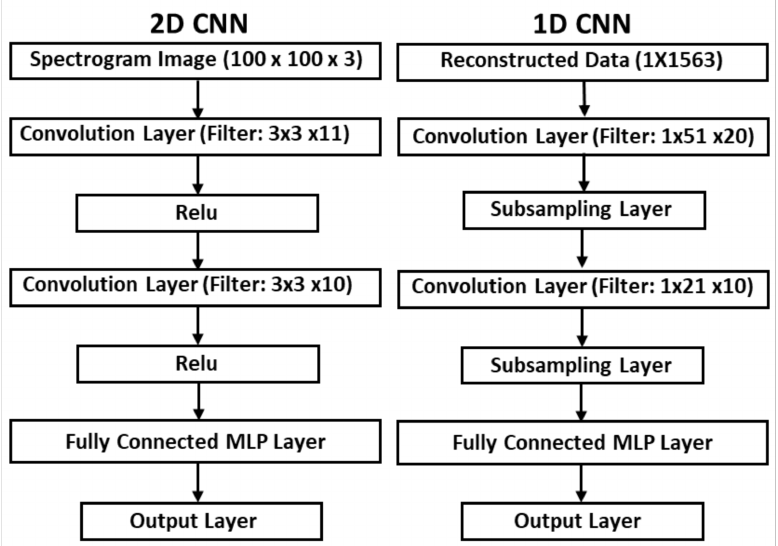
Figure 7. Structures of the 2D CNN and 1D CNN defect diagnosis